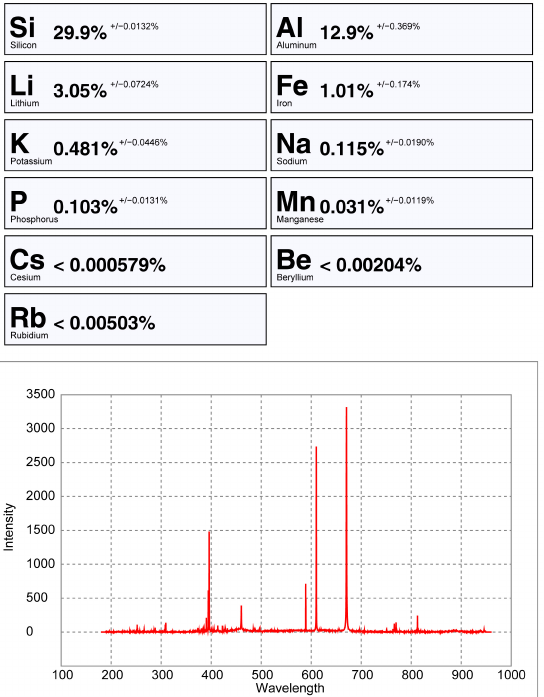
Figure 21. pLIBS analysis of the petalite sample 38-B1 with the Pet_Barroso calibration. Having two different calibrations for both minerals means that all the other chemical elements have at least two different calibration lines for each element, one only for spo- dumene and another only for petalite. For example, the equation of the calibration line for Li in spodumene is y = 1.9248 + 0.7010x and the calibration line for Li in petalite is y = 1.7937 +